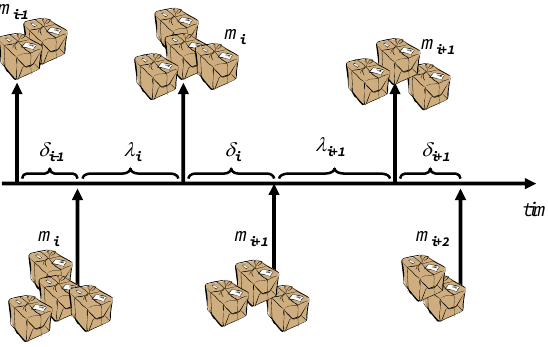
Fig. 4: A sequence of message arrivals and departures for KNR at a leaf. The message m A i is forwarded after δ i time slots at the leaf. δ i time slots later the next message